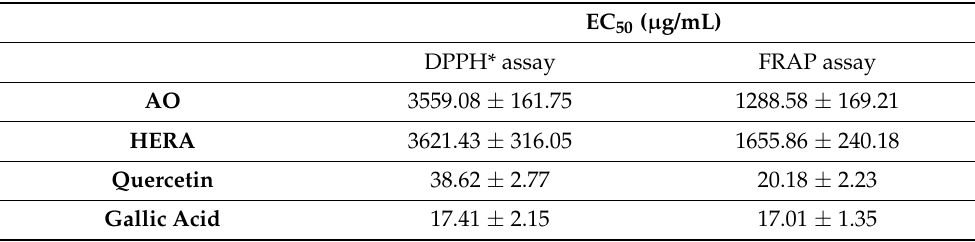
Table 6. The DPPH and FRAP EC 50 values of AO, HERA, quercetin, and gallic